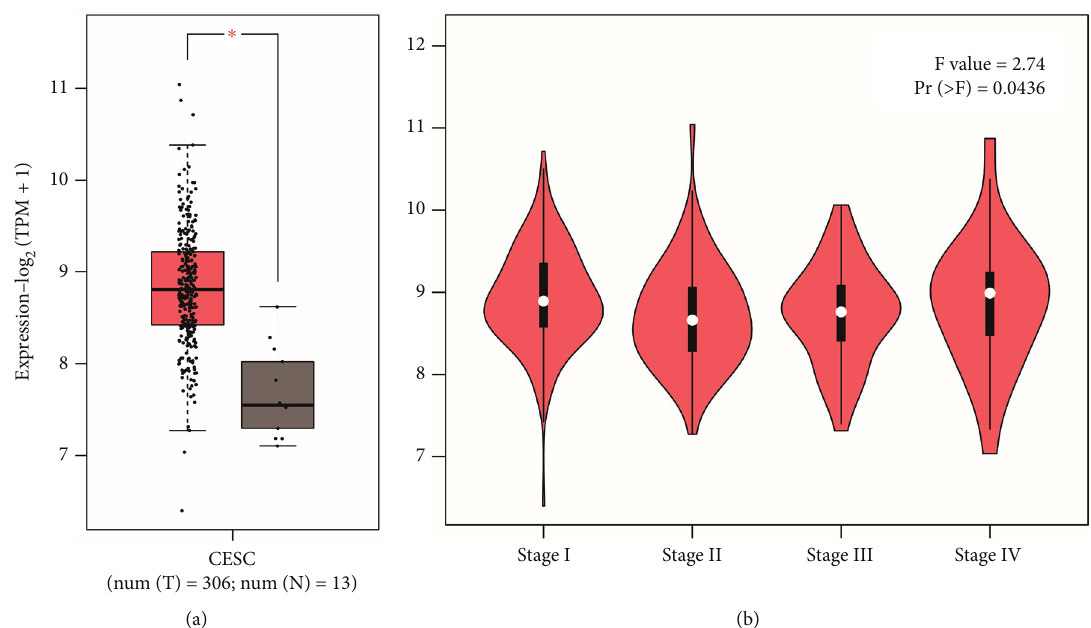
Figure 3: (a) Expression of PDIA3 gene in normal tissue and tumor tissue. (b) Relationship between PDIA3 expression and tumor staging.